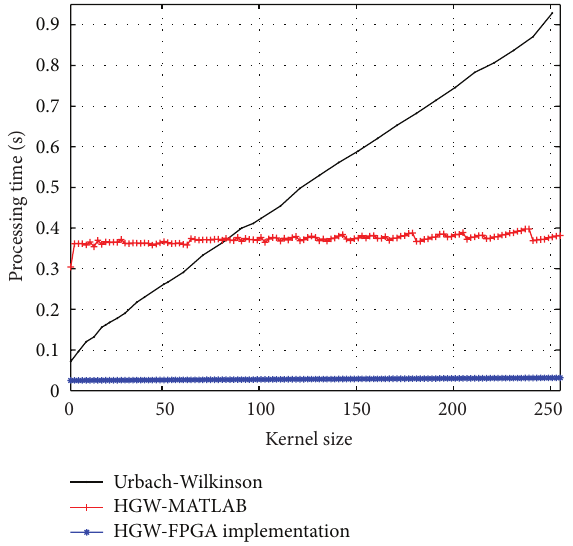
Figure 8: Processing time for the running max/min filters on an 2160 × 1440 input image with different kernel sizes using a single HGW module in the proposed architecture clocked at 250MHz. The processing time required for the Urbach-Wilkinson algorithm and the MATLAB implementation of the HGW algorithm is also shown for comparison.